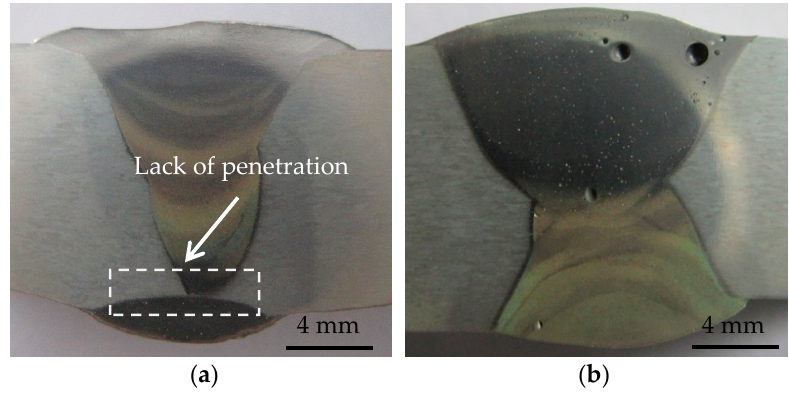
Figure 3. Cross-sectional macrostructures of representative welded joints: ( a ) sample No. 5; ( b ) sample No. 6.